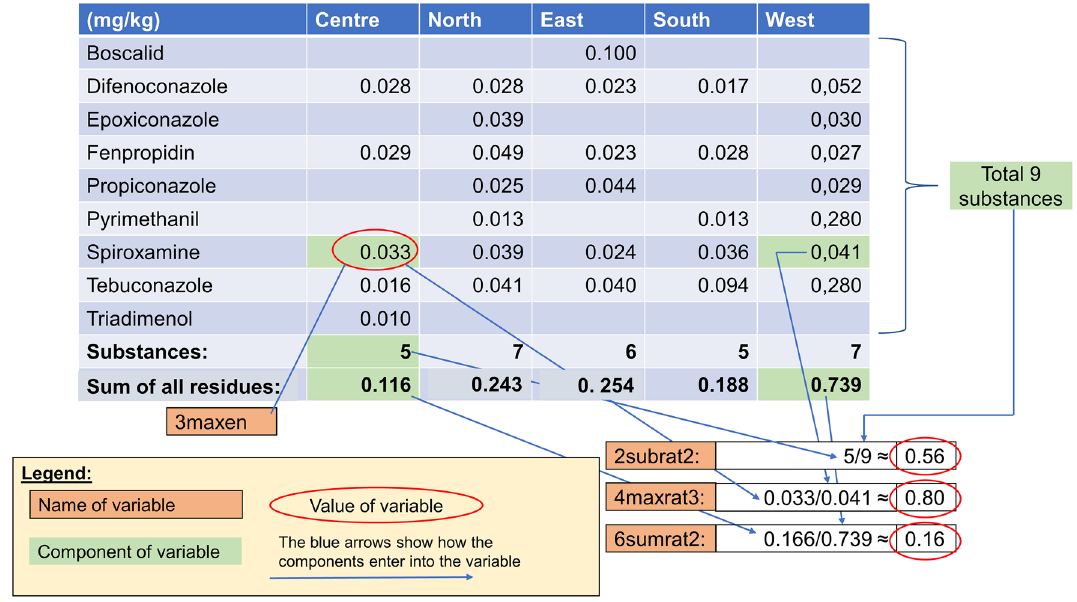
Figure 5. Raw data for case 49 (see also Fig. 4c), including an explanation of the four selected variables. A total of 5 fungicides were found in the centre, while in total 9 different fungicides were found in all samples, therefore the ratio of the two (called "2subrat2") is 5/9≈0.56. The value 0.033 mg/kg for spiroxamine is the highest figure out of the five residues found in the centre (here called "3maxcen"). We compare this to the highest value for spiroxamine among all samples, which is 0.041 mg/kg. The ratio of the two (called "4maxrat3") is 0.033/0.041≈0.80. The sum of all residues from the centre is 0.116 mg/kg, whereas the highest sum of residues from all samples is 0.739 mg/kg. The ratio of both, here called "6sumrat2", is